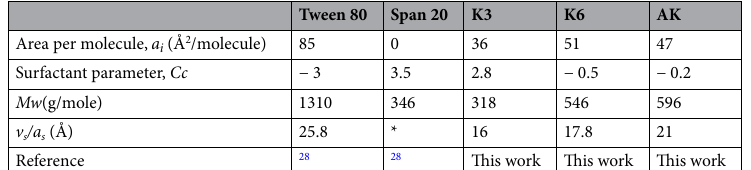
Table 1. TOC values and bottle test results for the S µ E in the presence of all three mixtures of this research. a TOC measurement uncertainty based on the TOC analyzer catalog.